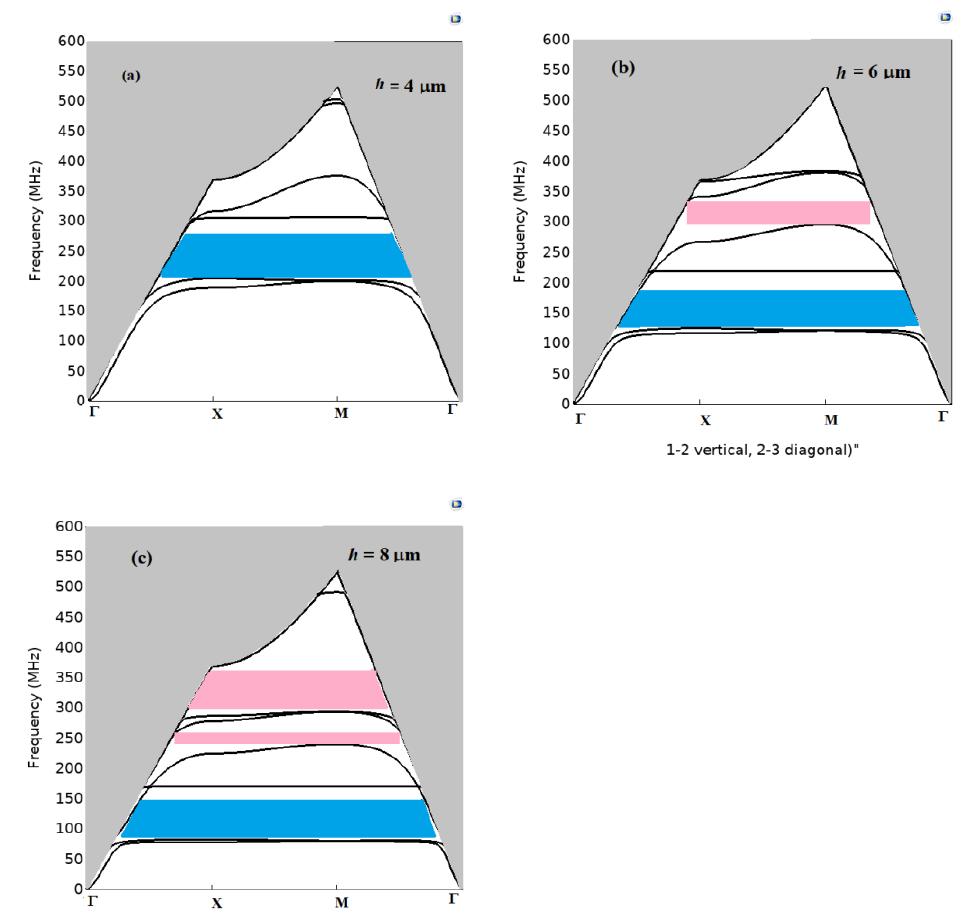
Figure 7. PnC band structures of lattice parameter a = 8 µm for AlN pillars of radius r = 3 µm and different values of h : ( a ) h = 4 µm, ( b ) h = 6 µm and ( c ) h = 8 µm.